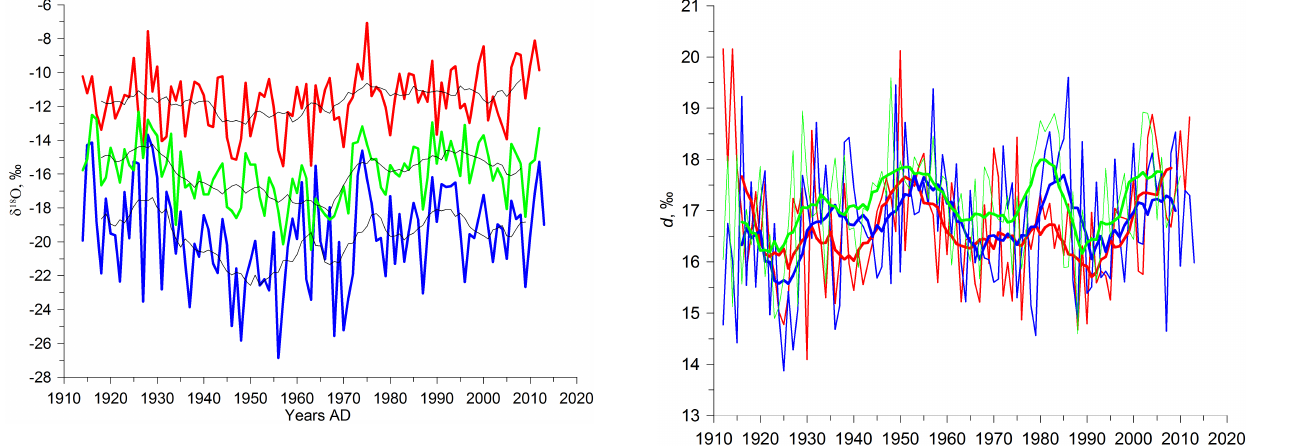
Figure 5. Annual variations in δ 18 O in the warm season (red line), in the cold season (blue line), and annual means (green line). Thin black lines show 10-year running means of these parameters.